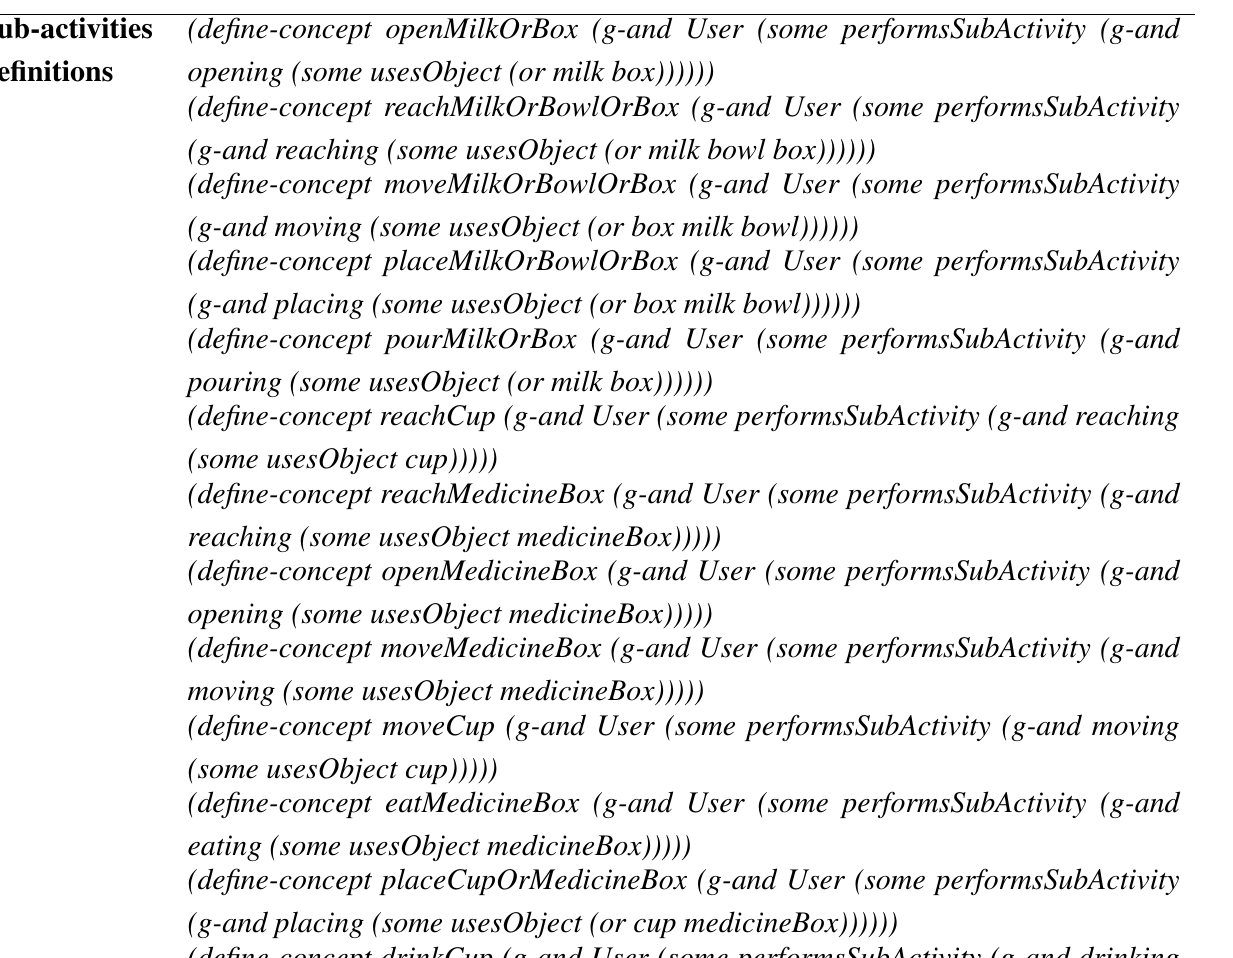
Table 2. Excerpt of fuzzy concepts used in the